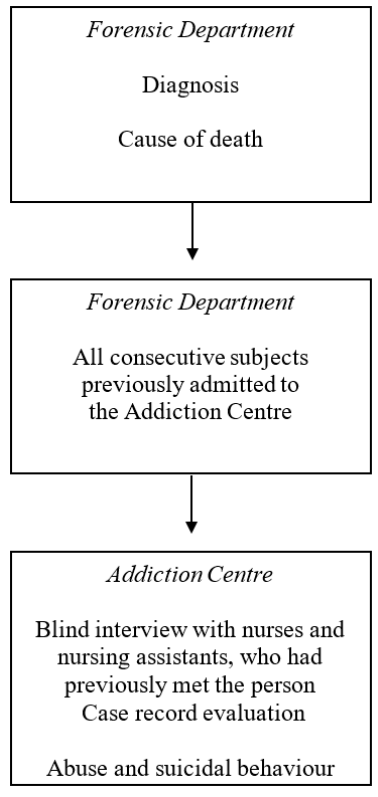
Figure 1. Sampling procedure (modified after [29]).